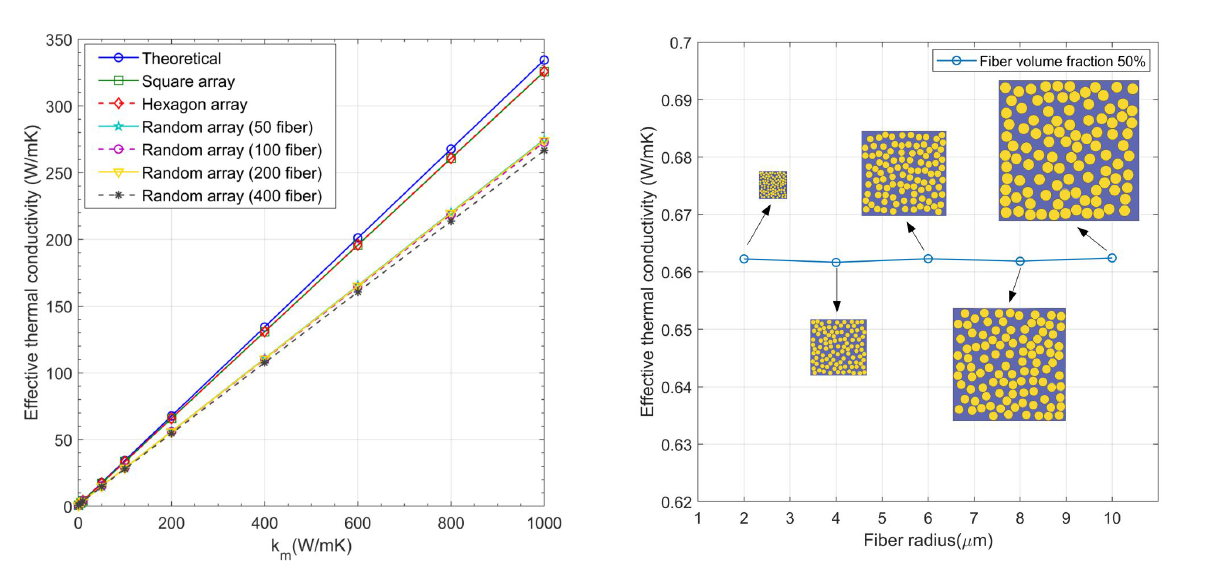
Figure 16: Effective thermal conductivity of composite in terms of the fiber